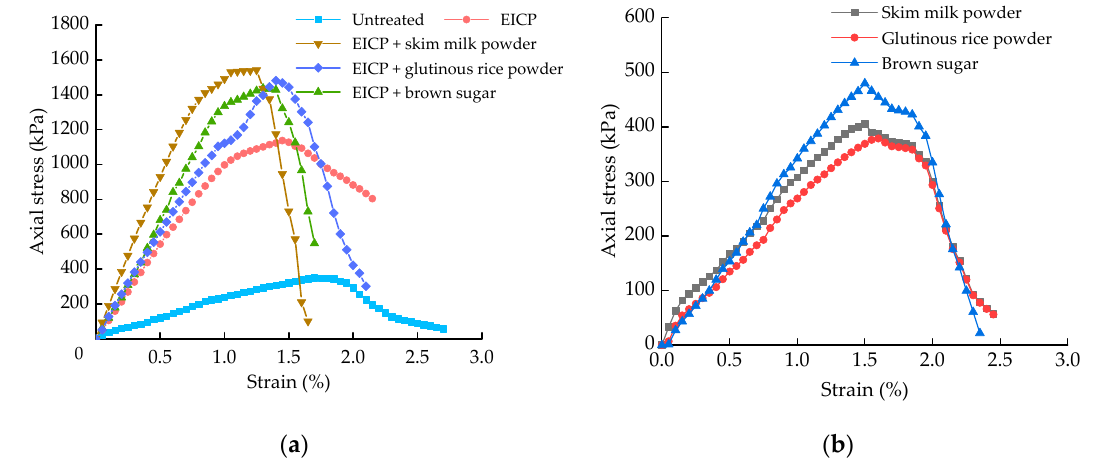
Figure 7. Axial stress-strain curves of representative samples treated by ( a ) EICP and improved EICP with organic material added; and ( b ) one kind of organic material.